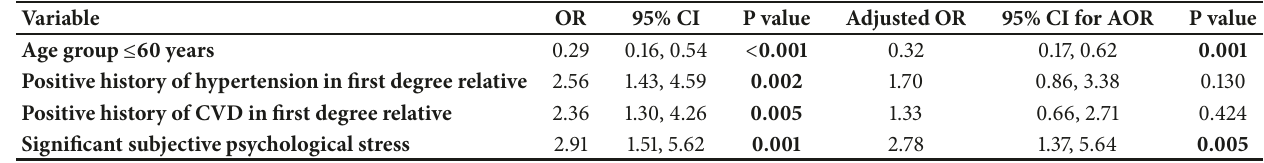
Table 4: Predictors of depression using logic regression